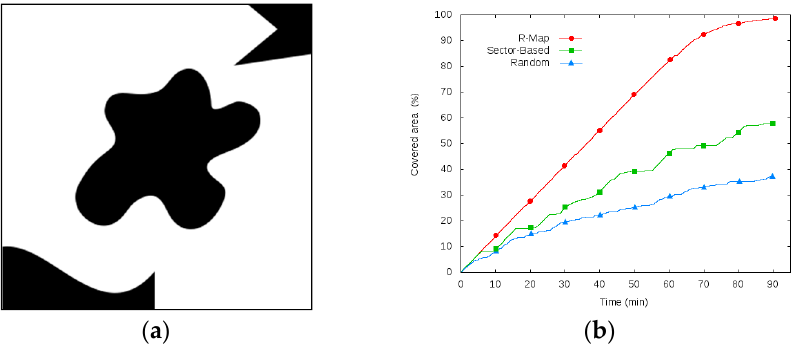
the green line is the sector based algorithm, the blue line is the random algorithm.